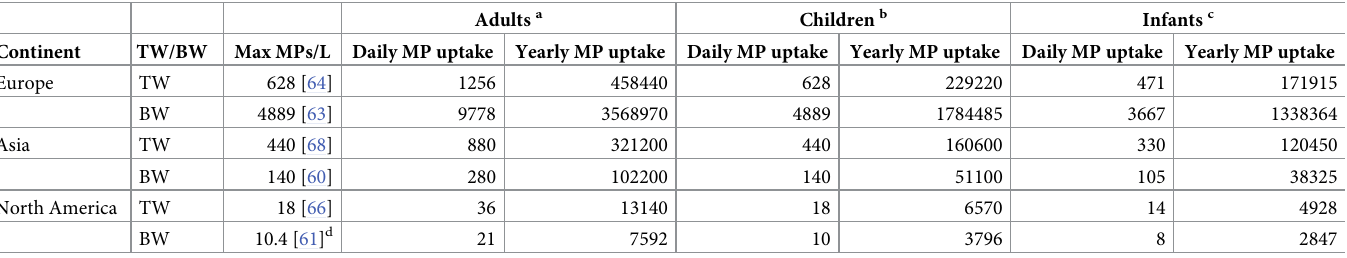
Table 4. Maximum daily and yearly MP uptake via water direct and indirect consumption per